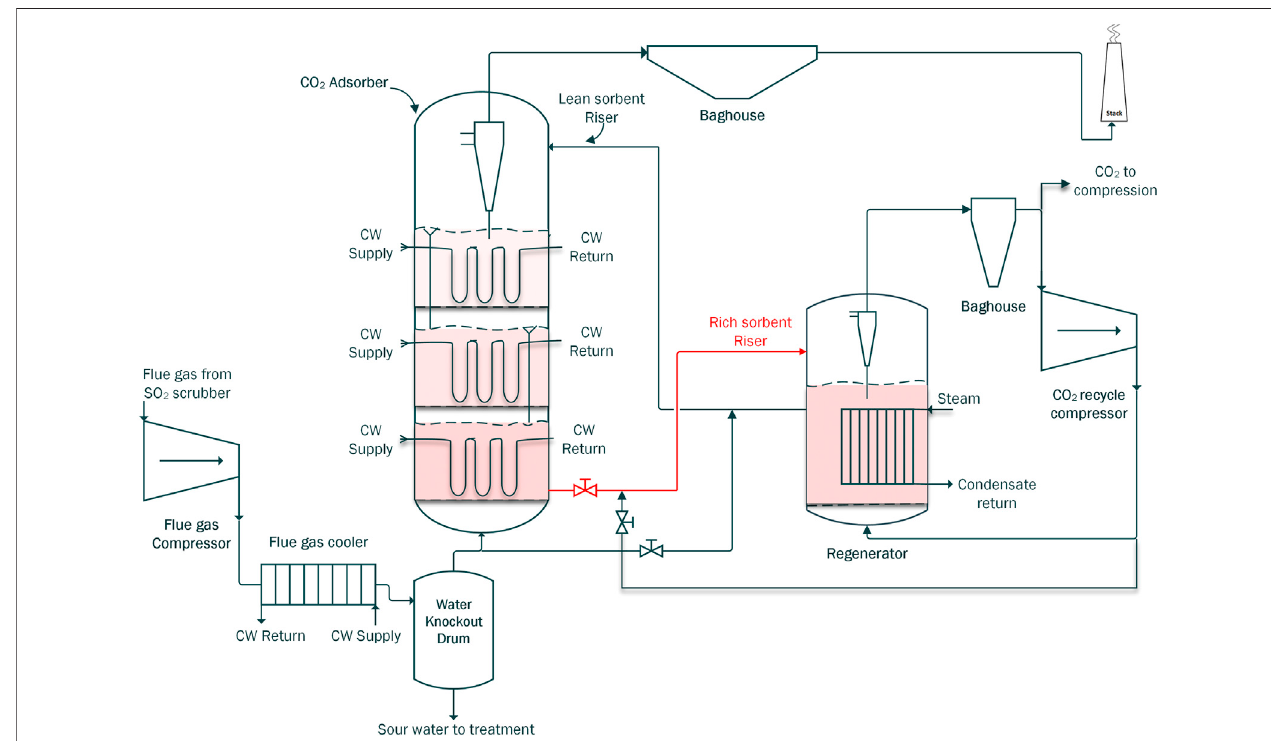
FIGURE 7 | Process fl ow diagram of the ADAsorb solid adsorption carbon capture process. Adapted from Sjostrom et al. (2016).